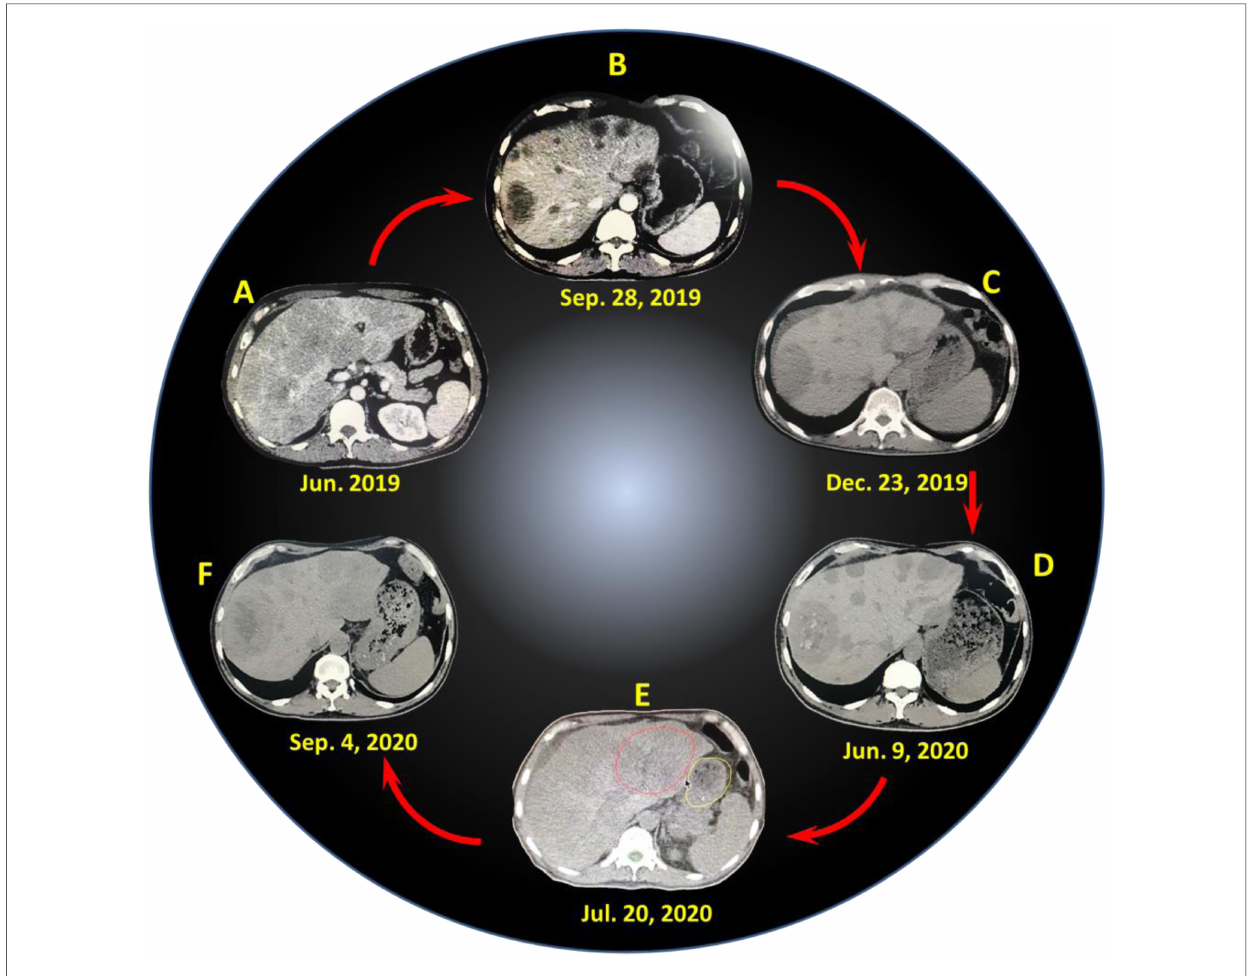
FIGURE 1 CT images of liver lesions at different time points: ( A ) June 2019 (before treatment), ( B ) September 28, 2019, ( C ) December 23, 2019, ( D ) June 9, 2020, ( E ) July 20, 2020, ( F ) September 4,